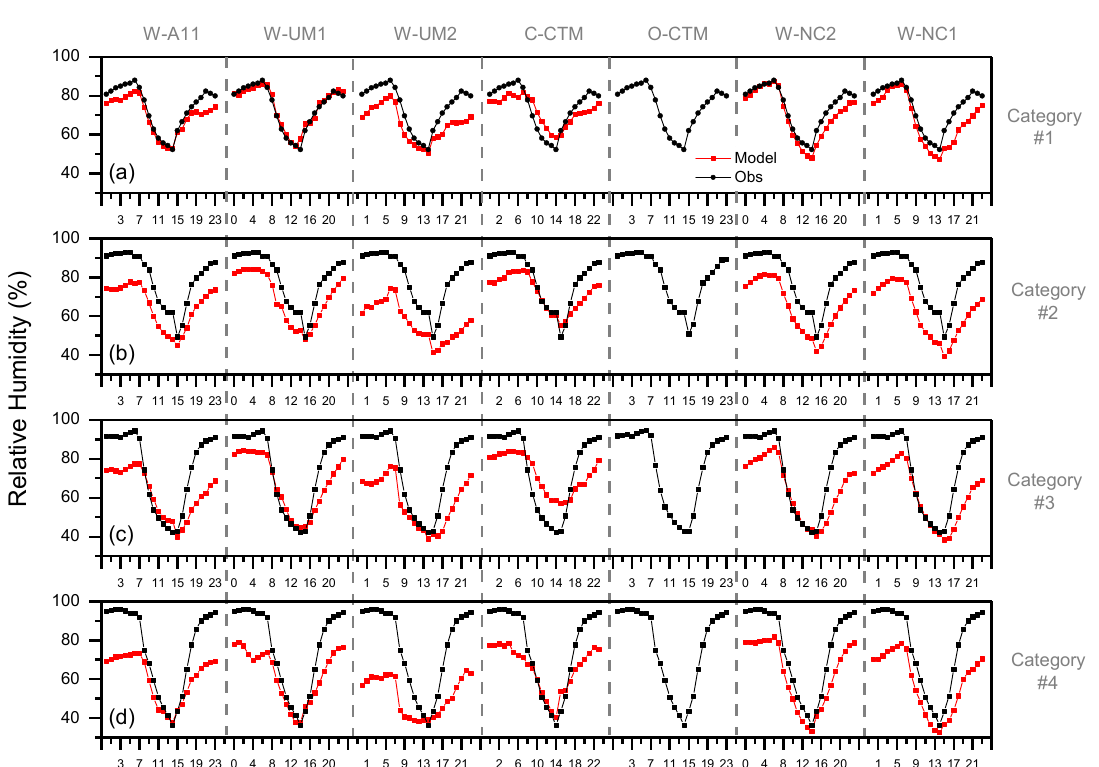
Figure 6. Diurnal composite observed and modelled 2 m relative humidity at Westmead. Panels a—d represent each of the four radon-based mixing categories (Table 1).